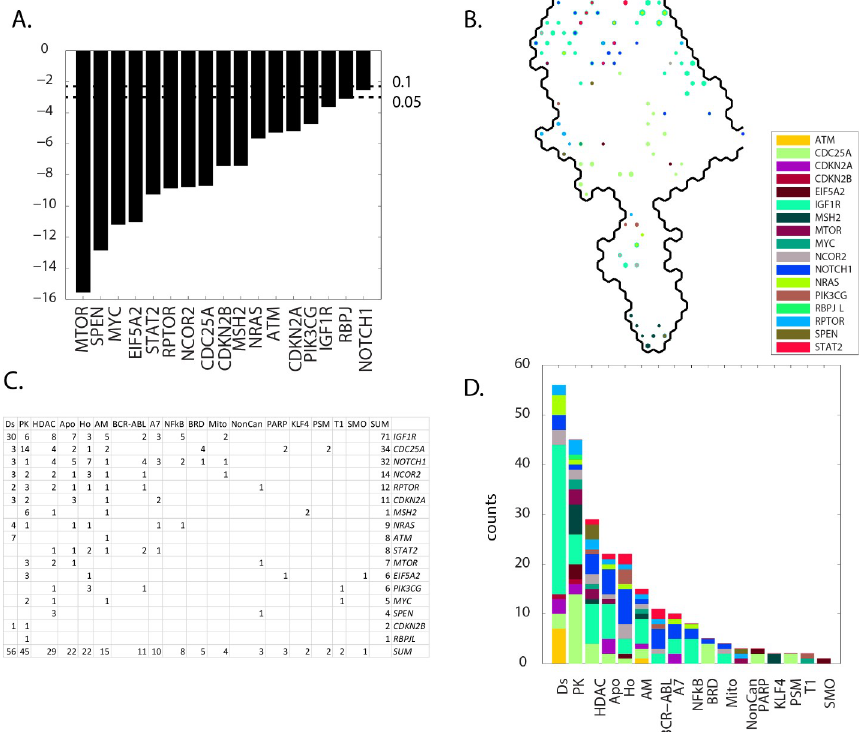
Fig 11. Results for group C(meta-clades 10 through 15). The SOM DTP region displayed in Panel B represents the boundary for meta-clades 10 through 15 (see the white border in Fig 8 Panel A ). S8 master_appendix sheet gp_C lists the table in Panel C. See the legend of Fig 9 for details. S15 master_appendix sheet gp_C_FDA lists the FDA compounds associated with these defective